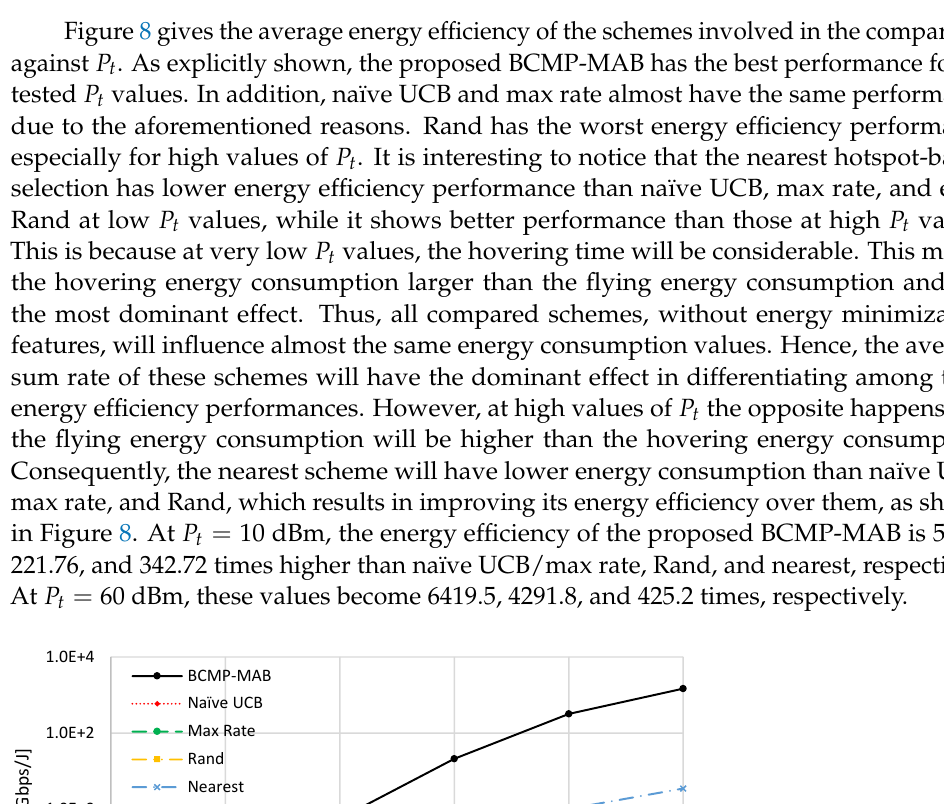
Figure 7. Average sum rate against P t .